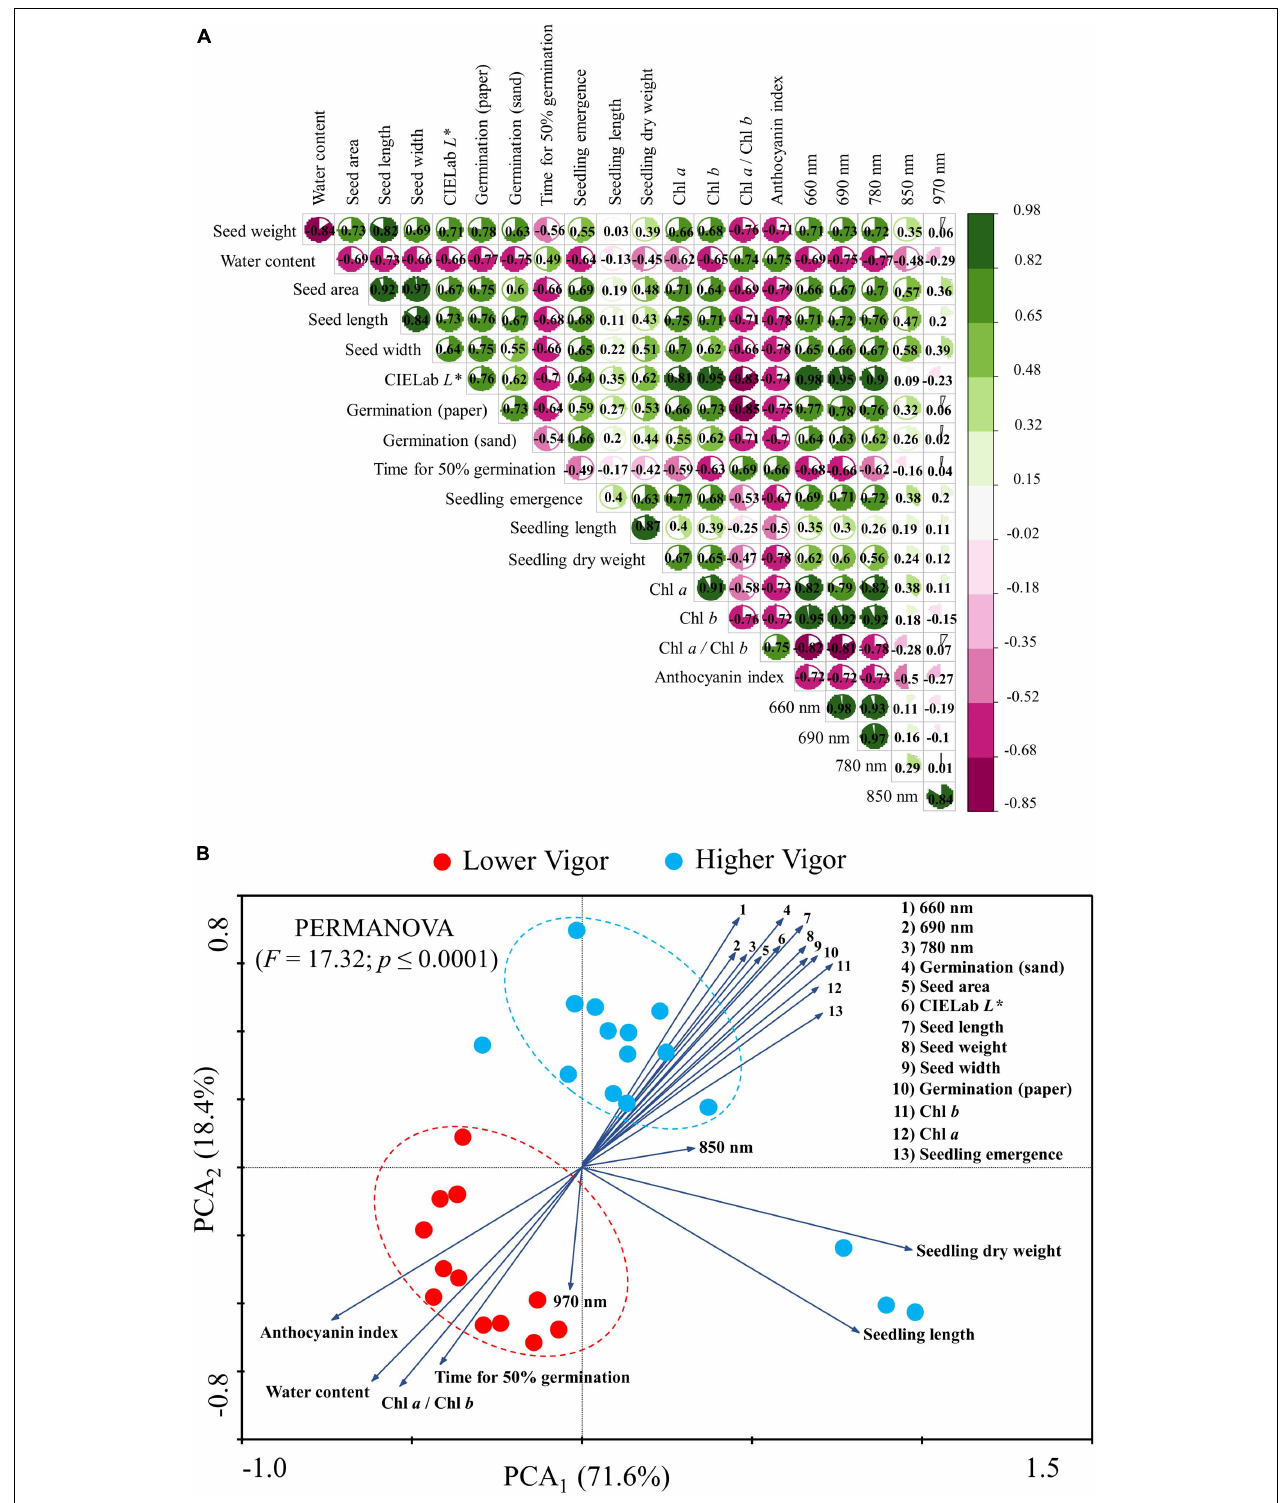
FIGURE 9 | Correlation matrix (A) and biplots of principal component analysis (PCA) (B) for physical optical descriptors, physiological, pigment, and reflectance of peanut seeds ( Arachis hypogaea L.; cv. IAC OL3) with lower (lots 1, 2, and 3; red circles) and higher vigor (lots 4, 5, 6, and 7; blue circles). The PCA vectors indicate the correlation between the classes (lower and higher vigor) and the dimensions PC 1 and PC 2 . We used the PERMANOVA test and the Bray-Curtis similarity index in the PCA to identify the difference between seed classes at a 1% significance.